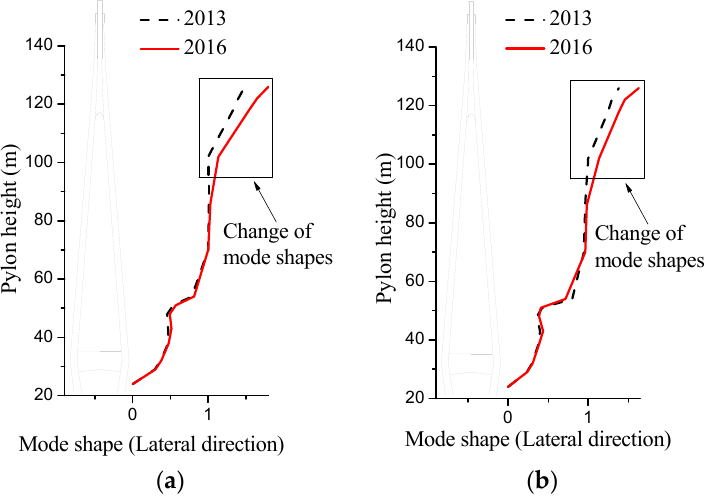
Figure 10. The change of the mode shapes of the pylon (only one pylon is shown). ( a ) The 1st lateral bending mode (antisymmetric) ( b ) The 1st lateral bending mode (symmetric).